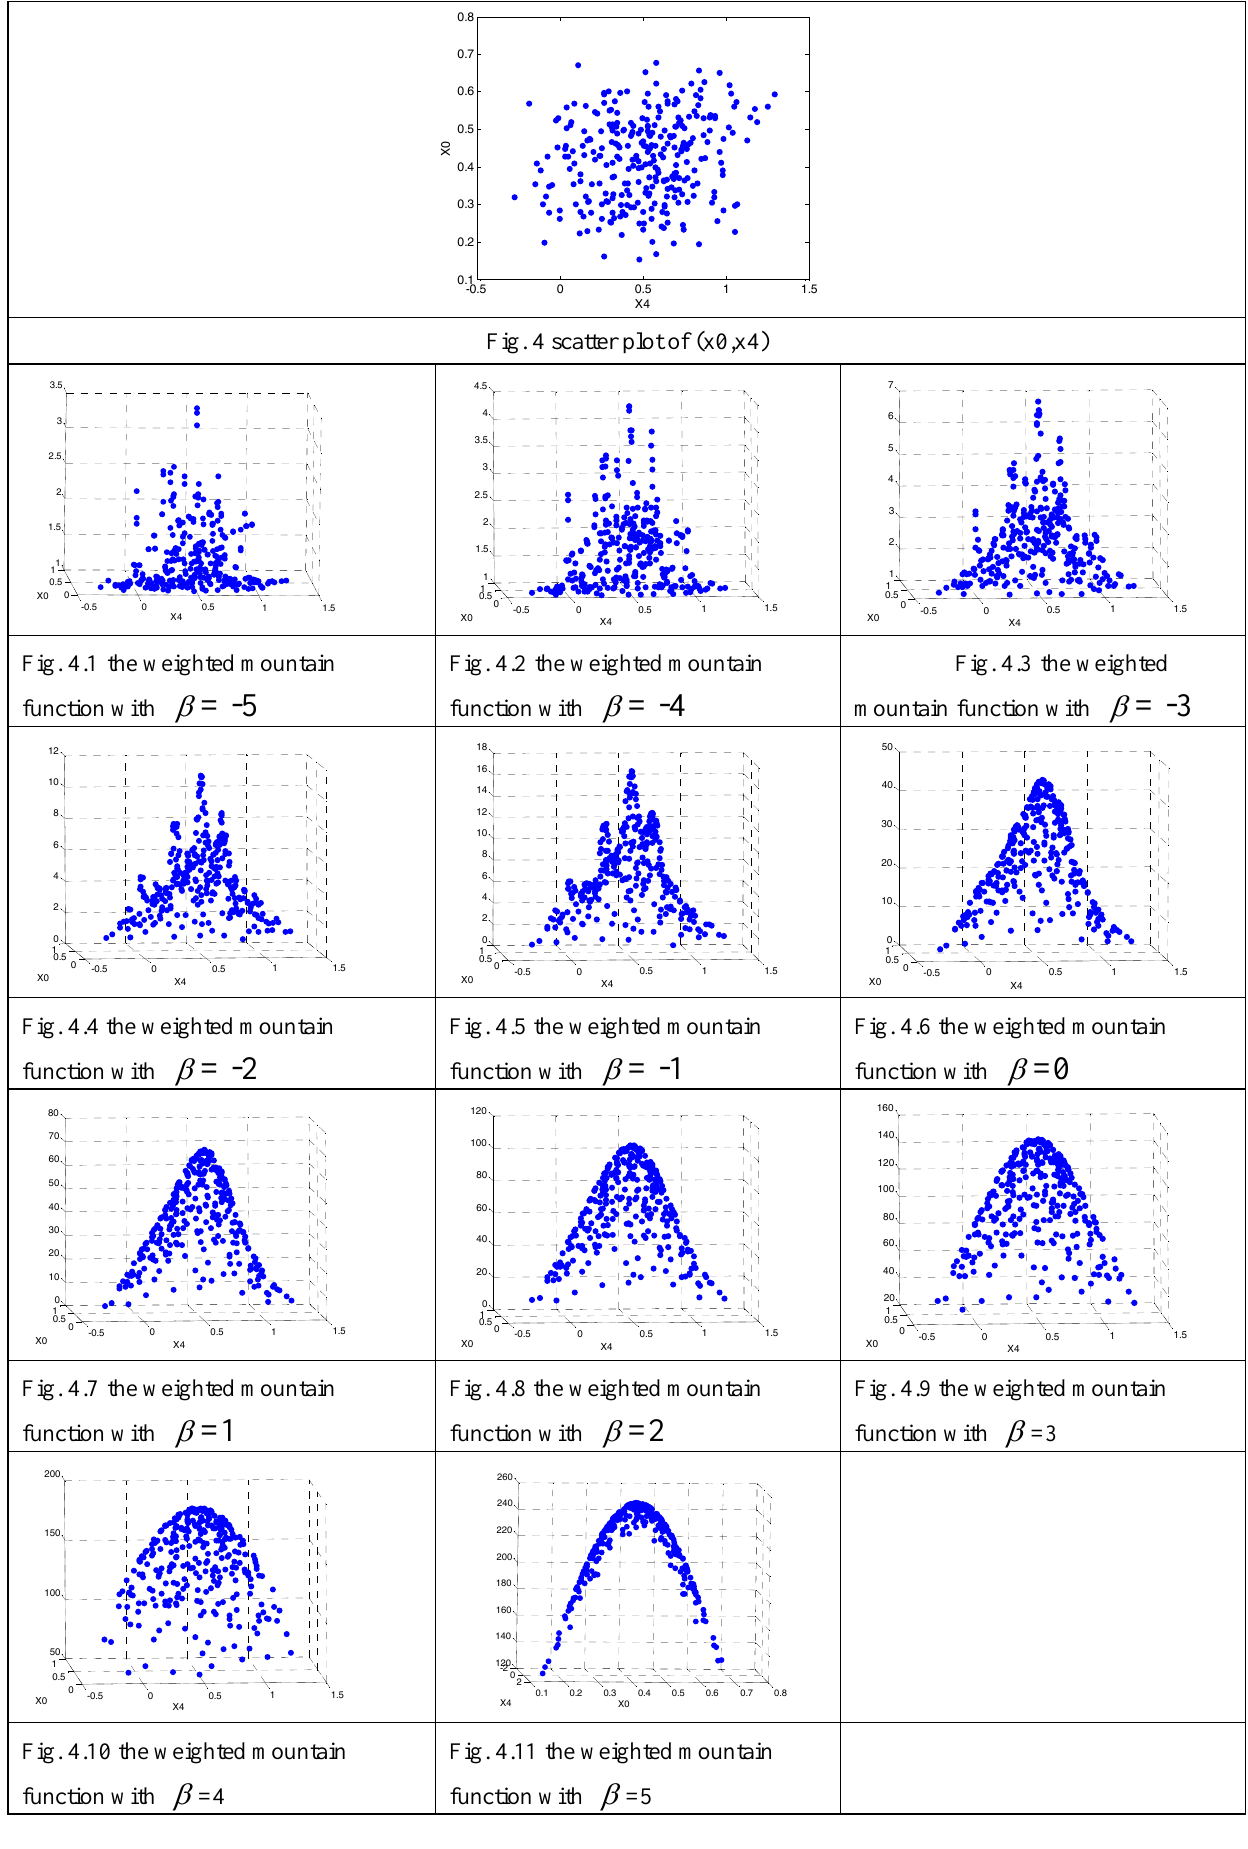
Fig. 4.11 the weighted mountain function with 